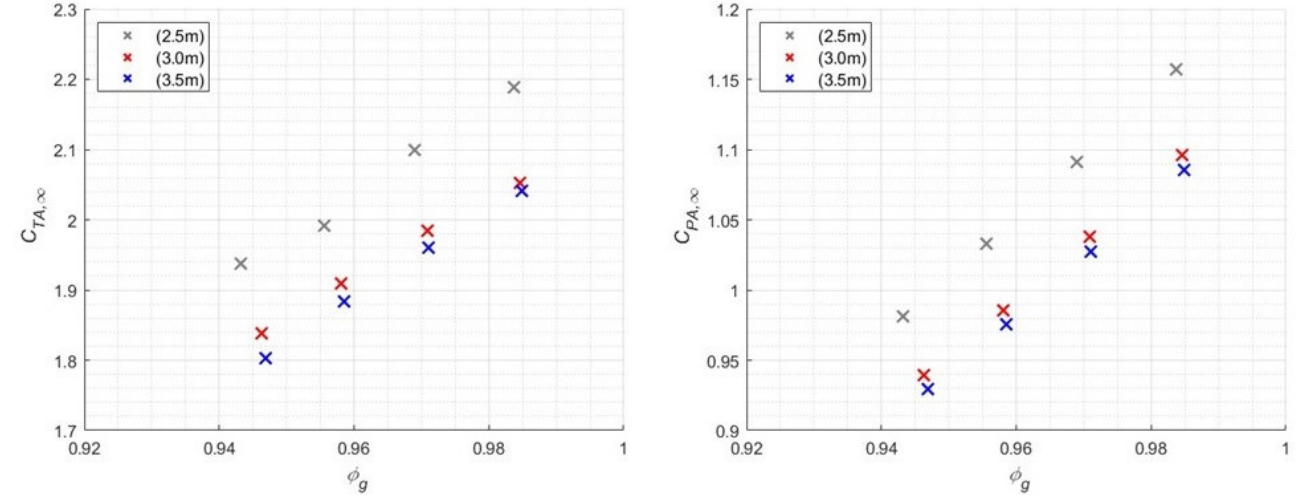
Figure 10. ( Left ) Effect of the turbine spacing d T on the array thrust coefficient C TA, ∞ vs. global inflow factor ϕ g for a plant of four arrays. ( Right ) Effect of the turbine spacing d T on the array power coefficient C PA, ∞ vs. global inflow factor ϕ g for a plant of four arrays. The three series of arrays from downstream to upstream are depicted with the same color from the right to left.